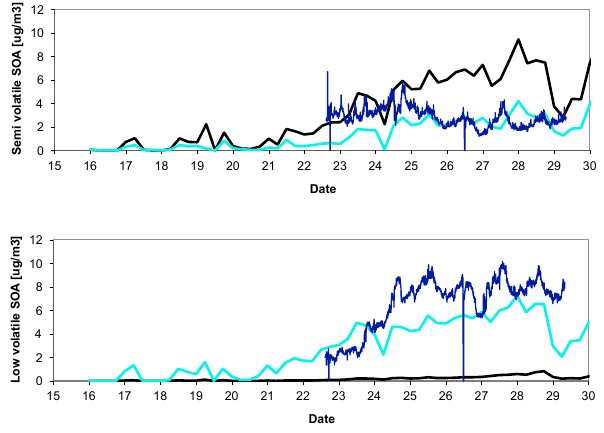
Fig. 6. Near-surface SOA aerosol mass concentration during June 2010 at Puy-de-Dôme, France. (a) Semi-volatile SOA, (b) low- volatile SOA. Dark blue line: AMS-measured, black line: 2. aging SOA – 1% aging, light blue line: 2. aging SOA – 10% aging. Mod- elled LV-SOA is compared to measured low-volatile SOA and the modelled sum of MV-SOA and SV-SOA is compared to measured semi-volatile SOA. Model simulation results correspond to those shown as black and light blue lines in Fig.